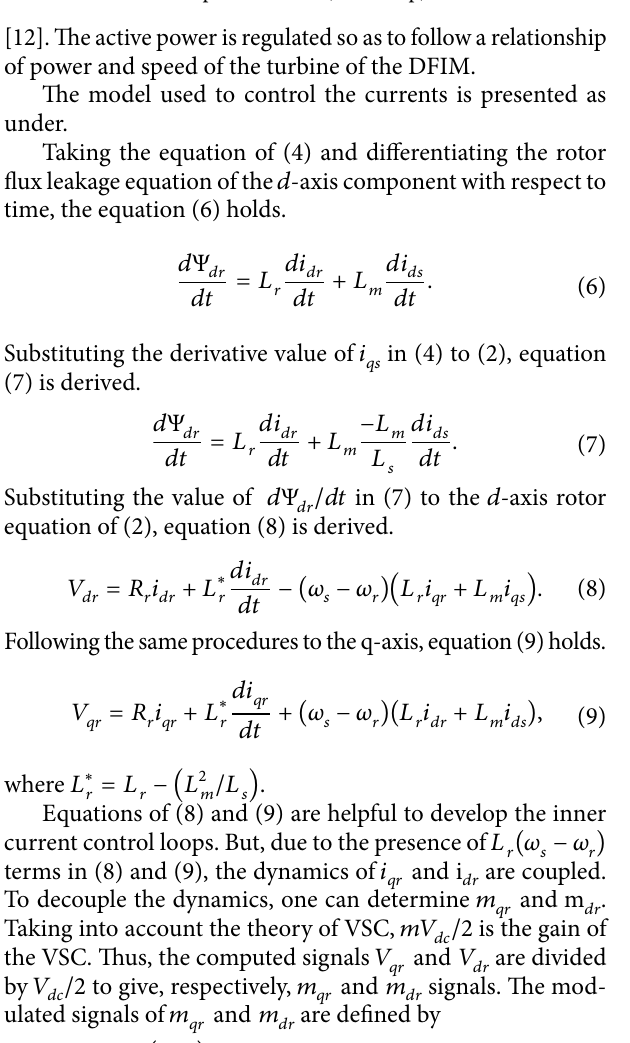
Figure 9: The PI active power control (outer loop) structure of the